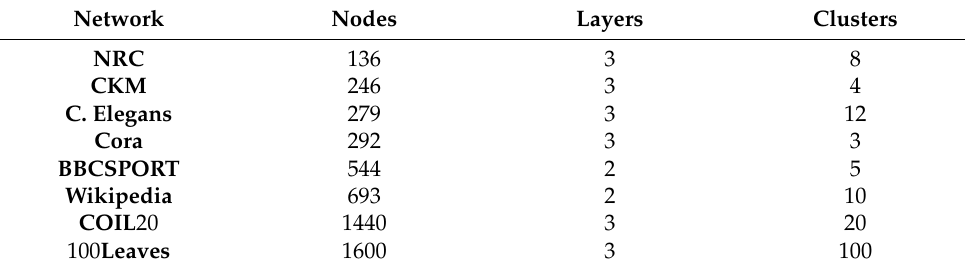
Table 3. Description of the real-world multiplex